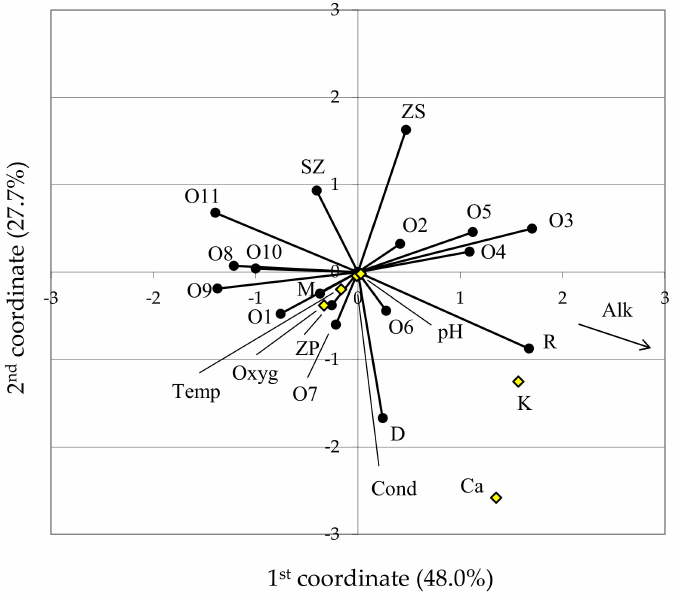
Figure 13. Position of monitoring sites determined by physicochemical parameters and macroele- ments in the space of the first two canonical varieties and spacing of these parameters in the dual space (trait coordinates rescaled and multiplied by